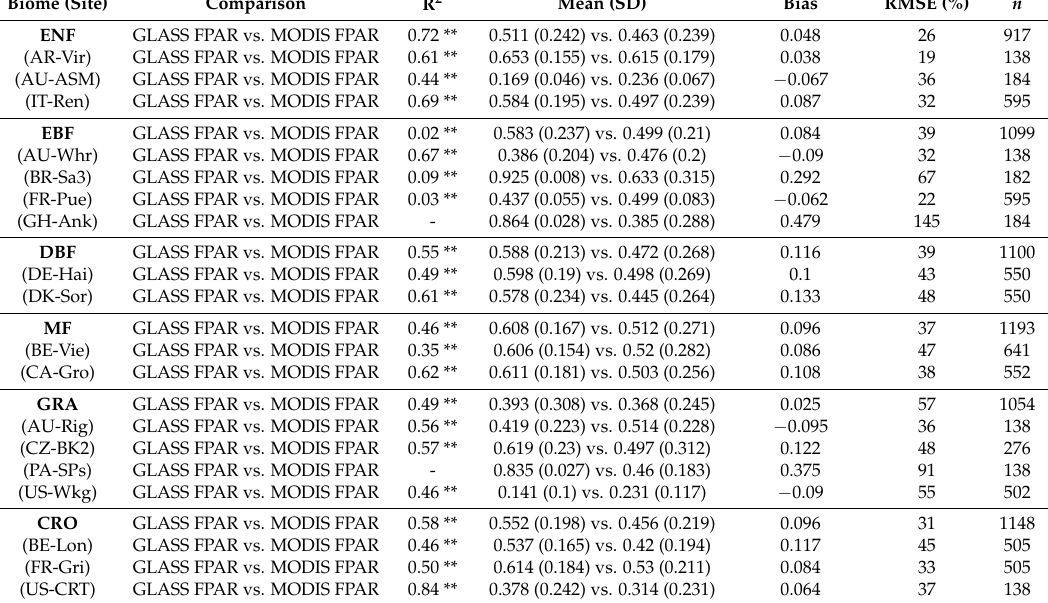
Figure 5. Comparison of the average FPAR from the GLASS LAI datasets (GLASS FPAR) and the MOD15A2H products (MODIS FPAR). Significance levels: ** p < 0.01. Table 4. Comparison of the FPAR derived from the GLASS LAI datasets (GLASS FPAR) with those from the MOD15A2H products (MODIS FPAR) for various biomes. ENF: evergreen needleleaf forests; EBF: evergreen broadleaf forests; DBF: deciduous broadleaf forests; MF: mixed forests; GRA: grasslands; CRO: croplands.